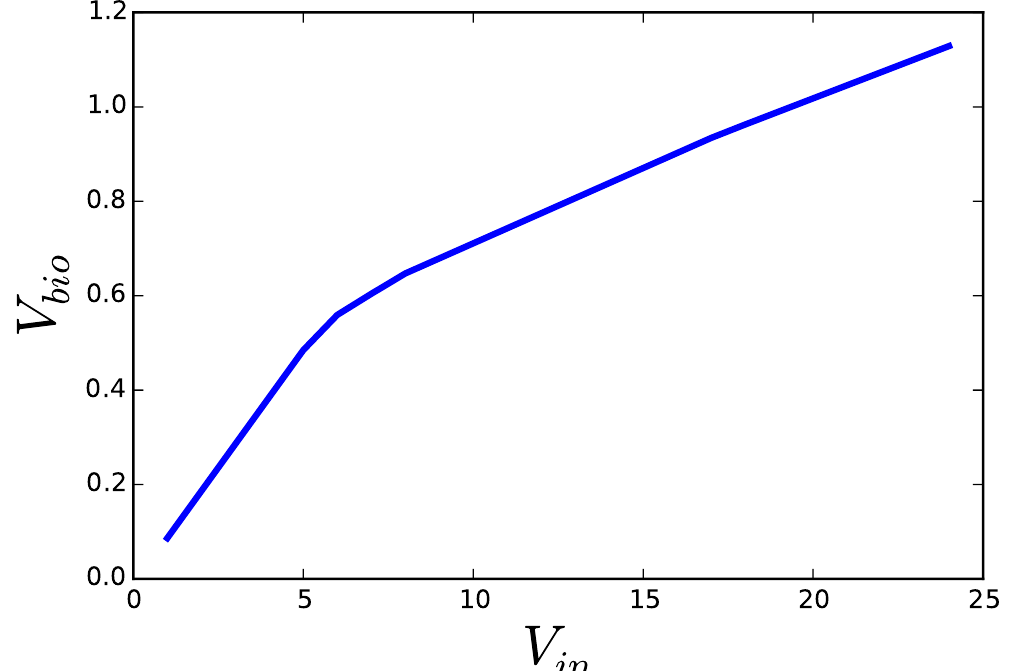
Figure 2. Results of applying the two optimization programs discussed in the text on a genome scale model of E. coli. Solving Equation (2) for increasing upper limits for glucose uptake ( V ) yields solutions ascending along the blue curve. Solving Equation (3) for in decreasing lower limits on the growth rate ( V ) results in solutions descending along the bio same curve. All optimizations were performed using COBRA for python version 0.3.2 and the E. coli model iJO1366 included with the software. All fluxes were optimized with their default limits except EX_o2_e, for which a lower bound of − 10.0 was